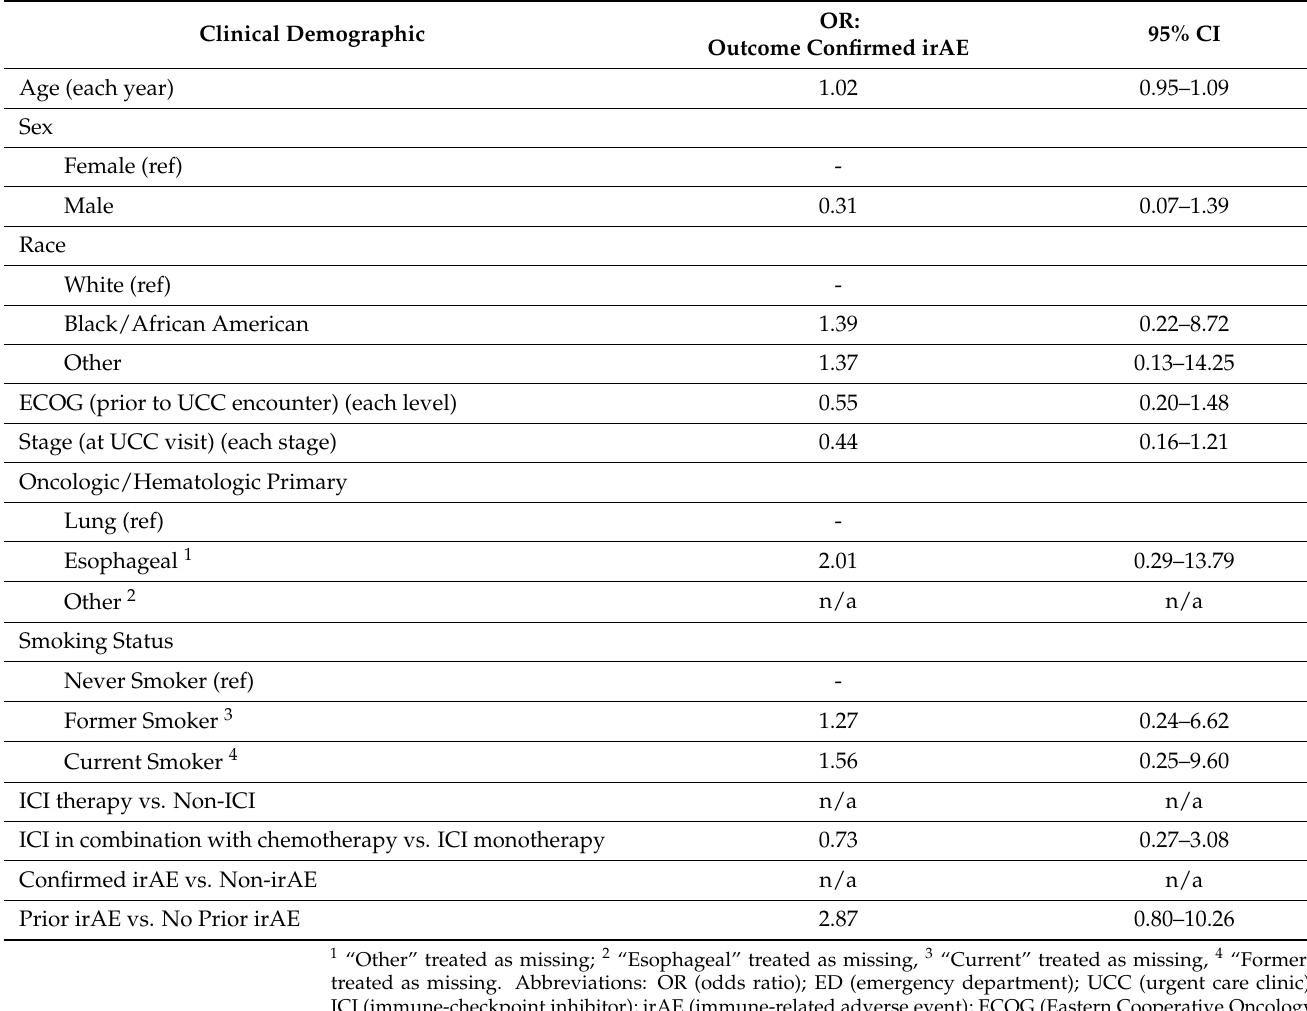
Table 3. Associations between clinical features and diagnosis of irAE.